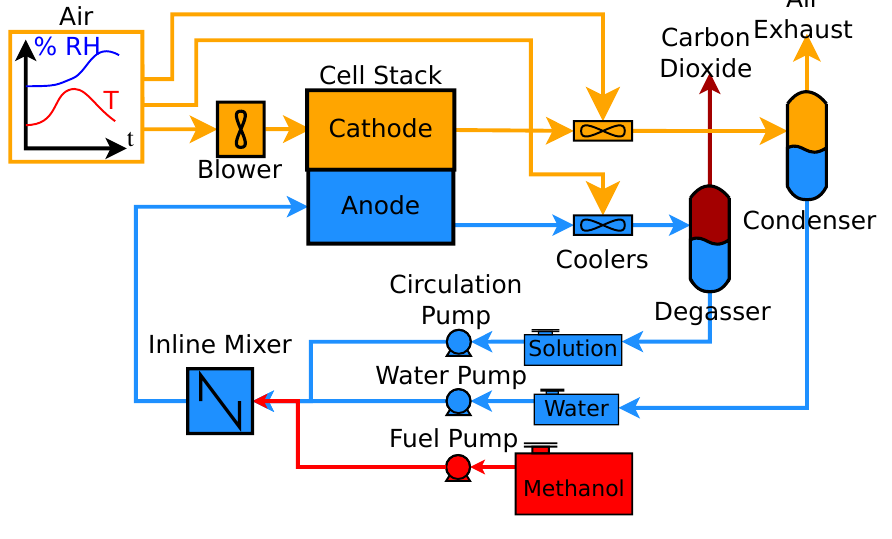
Figure 3. The process layout of the separate tank